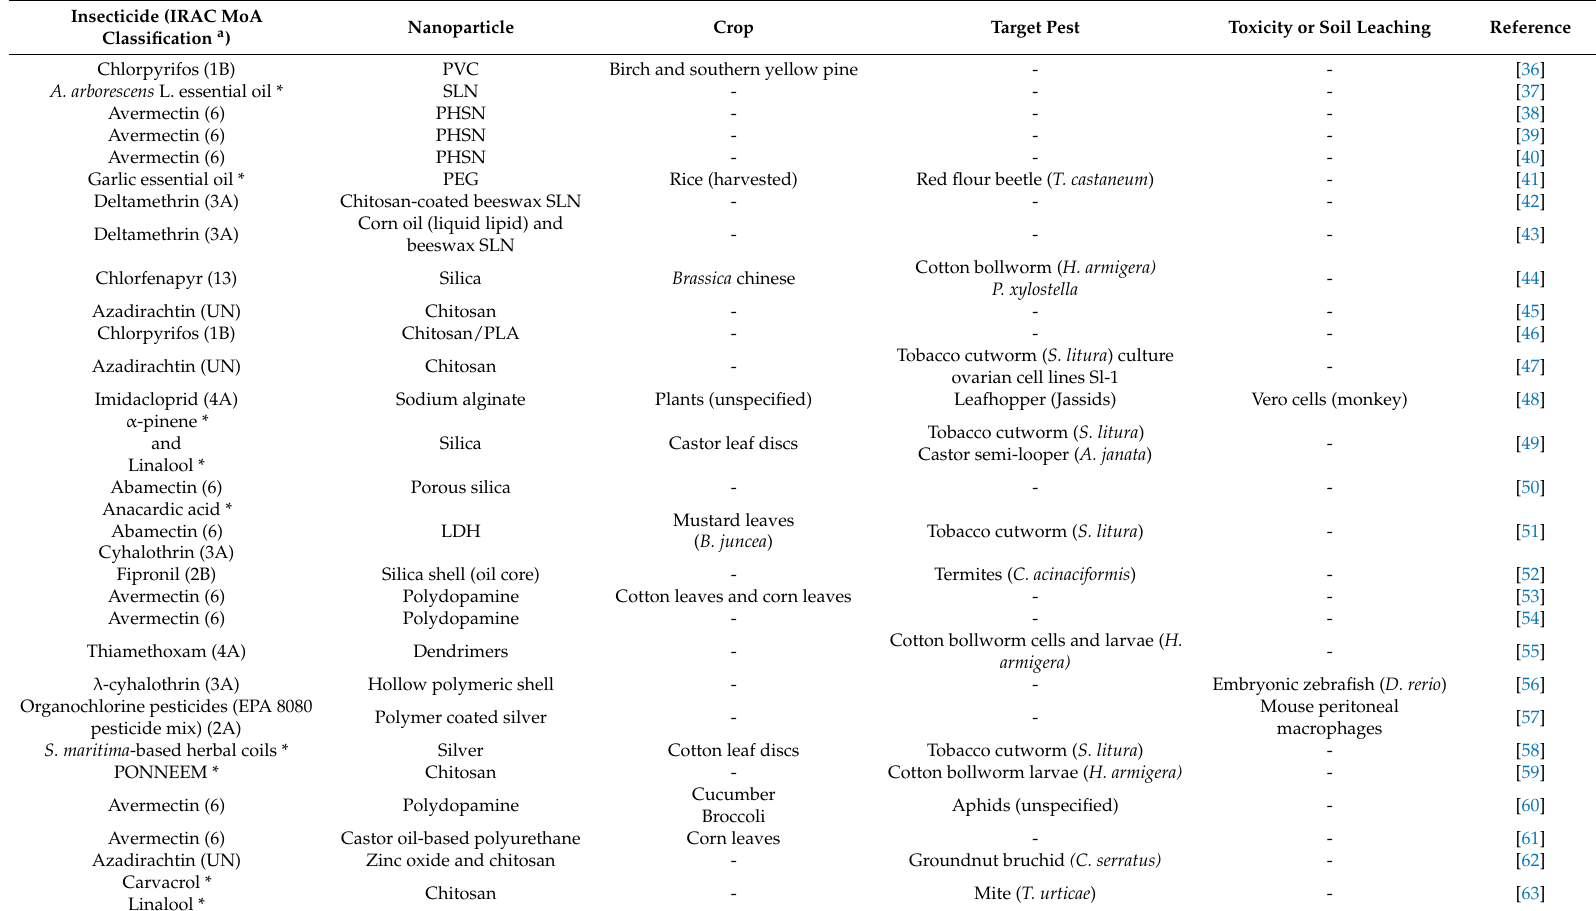
Table 1. Summary of studies utilizing nanoparticles as carriers of insecticides or actives that target insect